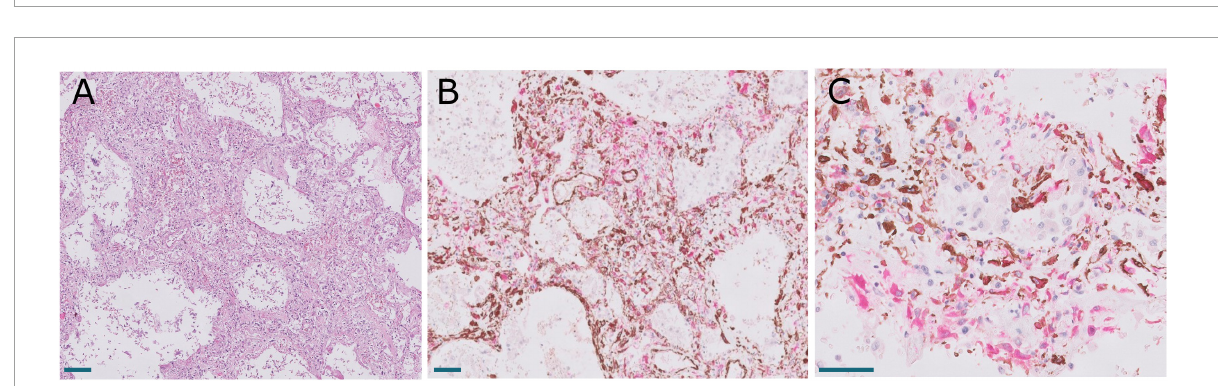
FIGURE10 Lung lesions in Pt. 25 with 41 days of evolution. (A) Hematoxylin and eosin showing interstitial enlargement. Scale bar: 100 µ m. (B,C) . Dual immunostaining with SPARC (magenta) and α -muscle actin showing a heterogeneous population of fibroblast expressing different levels of both proteins. Scale bar: 100 µ